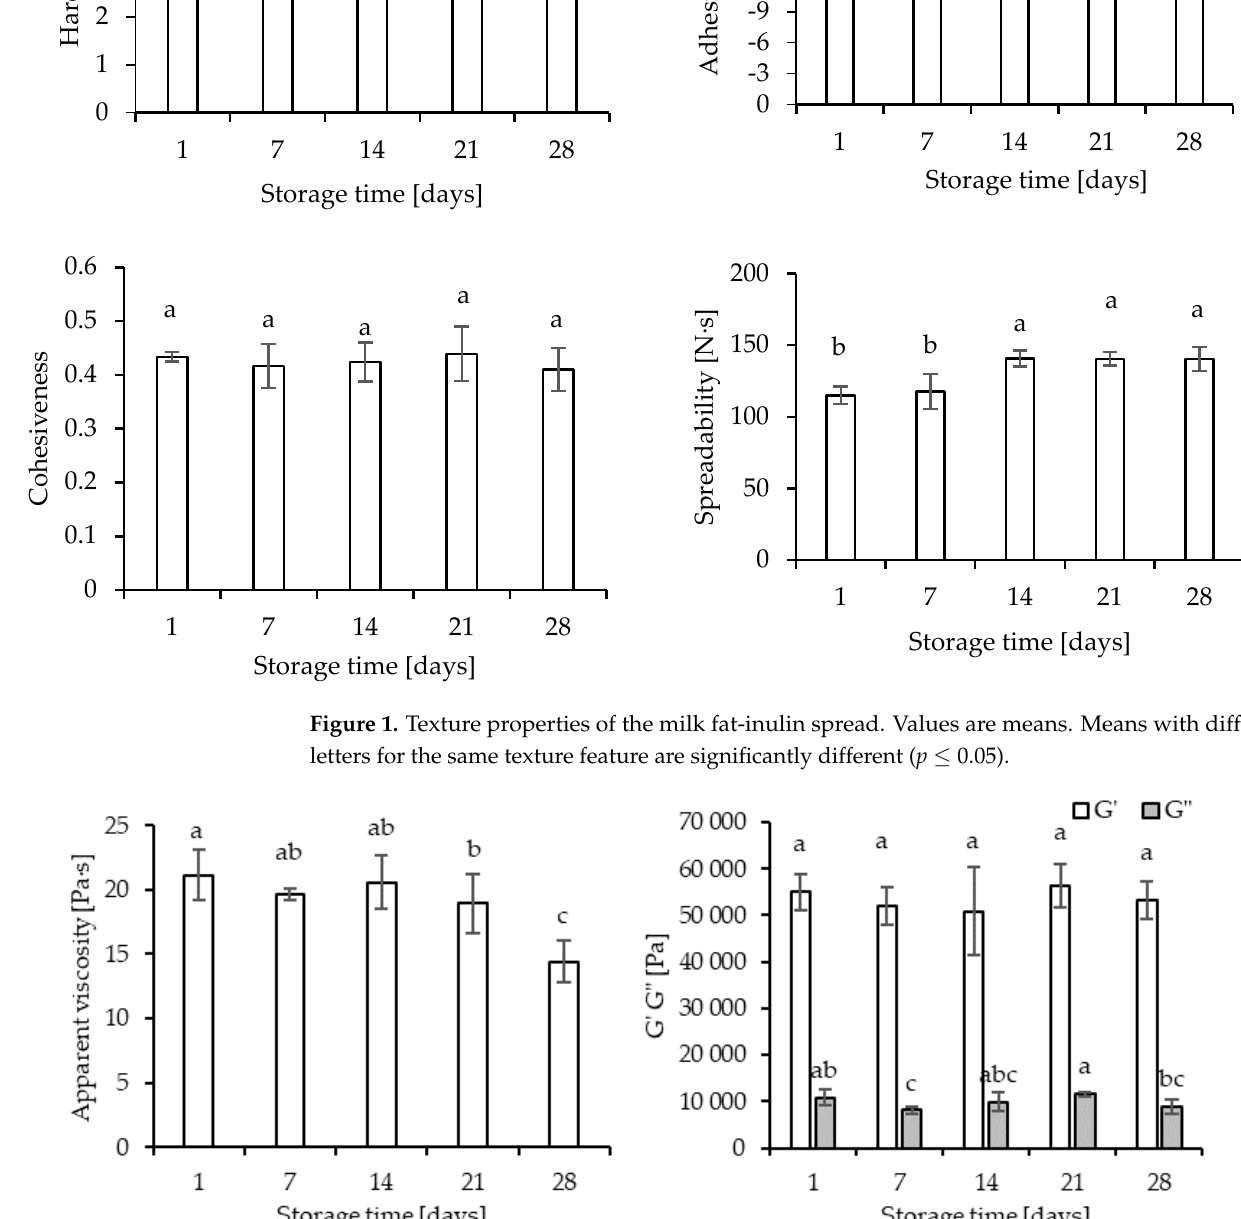
Figure 2. Apparent viscosity. Elastic (G’) and loss (G”) moduli of the milk fat–inulin spread. Values are means. Means with different letters for the same rheological feature are significantly different ( p ≤ 0.05).